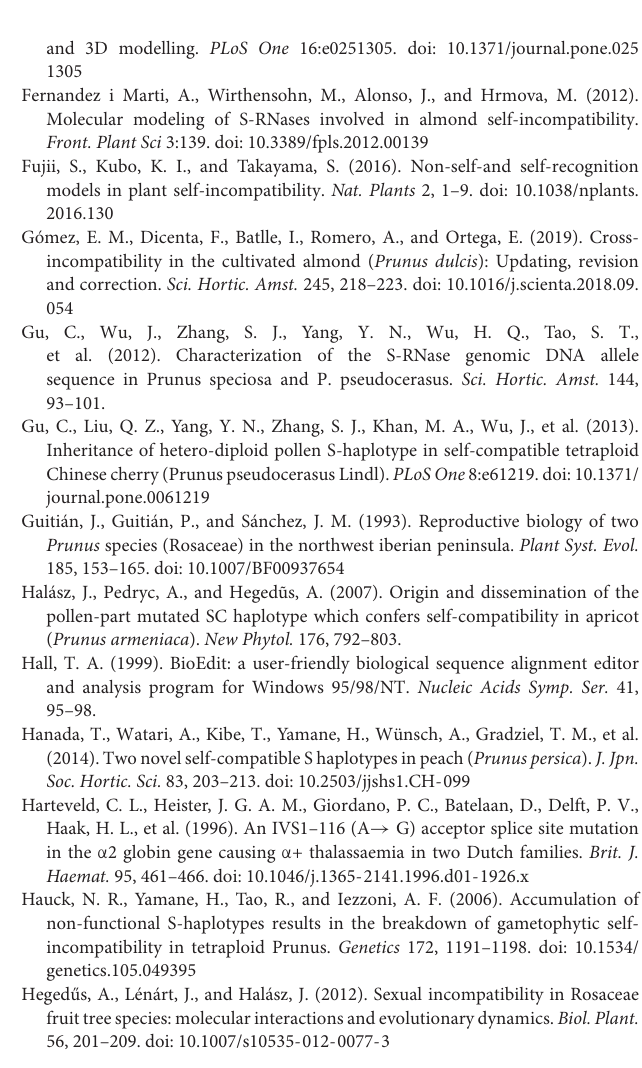
left half) of Prunus laurocerasus partial S - RNase alleles. The putatively truncated protein sequences of the S 5m - and S 18m -alleles were not included in the analysis. Supplementary Table 3 | The results of the BLASTP analysis performed on the deduced amino acid sequence of Prunus laurocerasus putative S-RNase alleles determined in this work, their corresponding NCBI Protein database accession number, percentage of query coverage and identity, the E -value of alignment score and the closest homologs (species name, allele label and accession number). Supplementary Table 4 | Pairwise identity (%) matrix of the deduced amino acid sequences of 20 partial Prunus laurocerasus and 58 other Prunus S - RNase alleles. Supplementary Table 5 | Sequence identity percentages of the 2nd intron and deduced amino acid sequences of Prunus laurocerasus and their most similar Prunus S -RNases. Green and red background color indicate great and small identities, respectively. Intron identity values are missing when only the mRNA sequence was available and hence, the comparison was not feasible. The asterisk ( ∗ ) indicates the database sequence was shorter or deficient. Amino acid replacements are shown in different regions of the S -RNase protein and amino acid positions. Orange and blue color show mutations occurring in a single sequence or group of sequences,